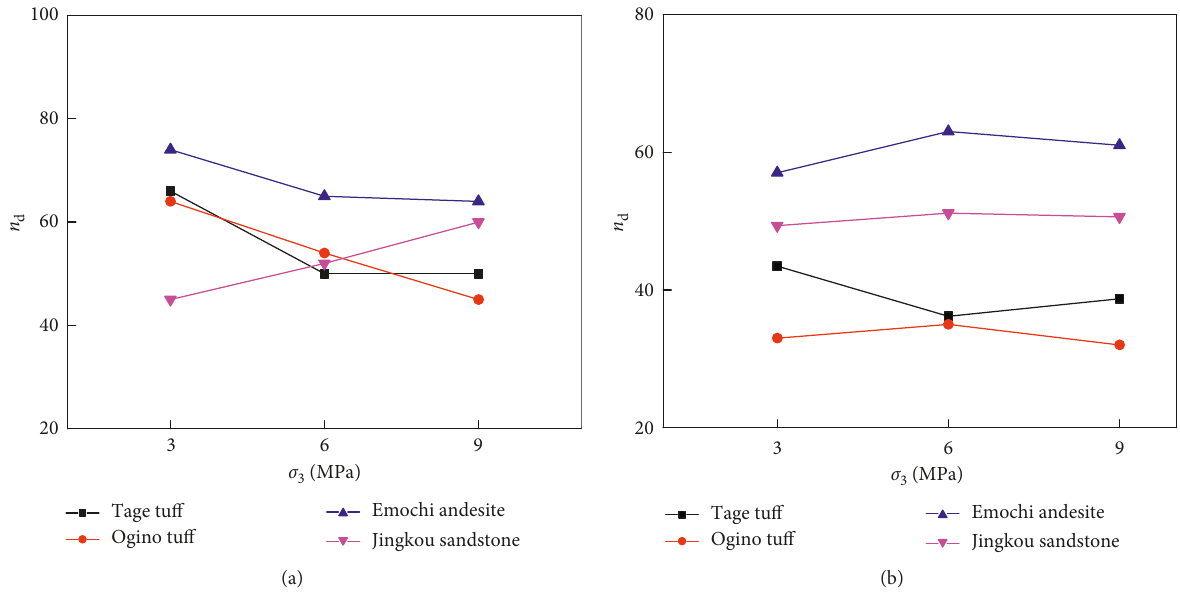
Figure 9: Loading-rate dependence index in the postfailure region with respect to the confining pressure under (a) air-dried, (b) wet